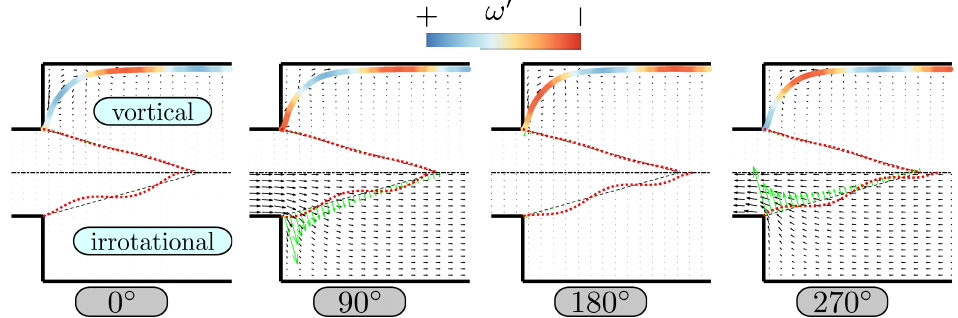
Figure 8. Predictions of the UD model of a harmonically forced flame (80 Hz, 2% u blk , C r = 0.4). Shown are four snapshots taken at phases from 0 ◦ to 270 ◦ relative to the forcing signal. Displacement of the flame front ( ) is scaled by a factor of 7. Top: vortical flow component, with color along the shear layer indicating the strength of vorticity fluctuations. Bottom: irrotational flow component. The flame normal velocity is represented by green arrows (scaled by a factor of 4 for better